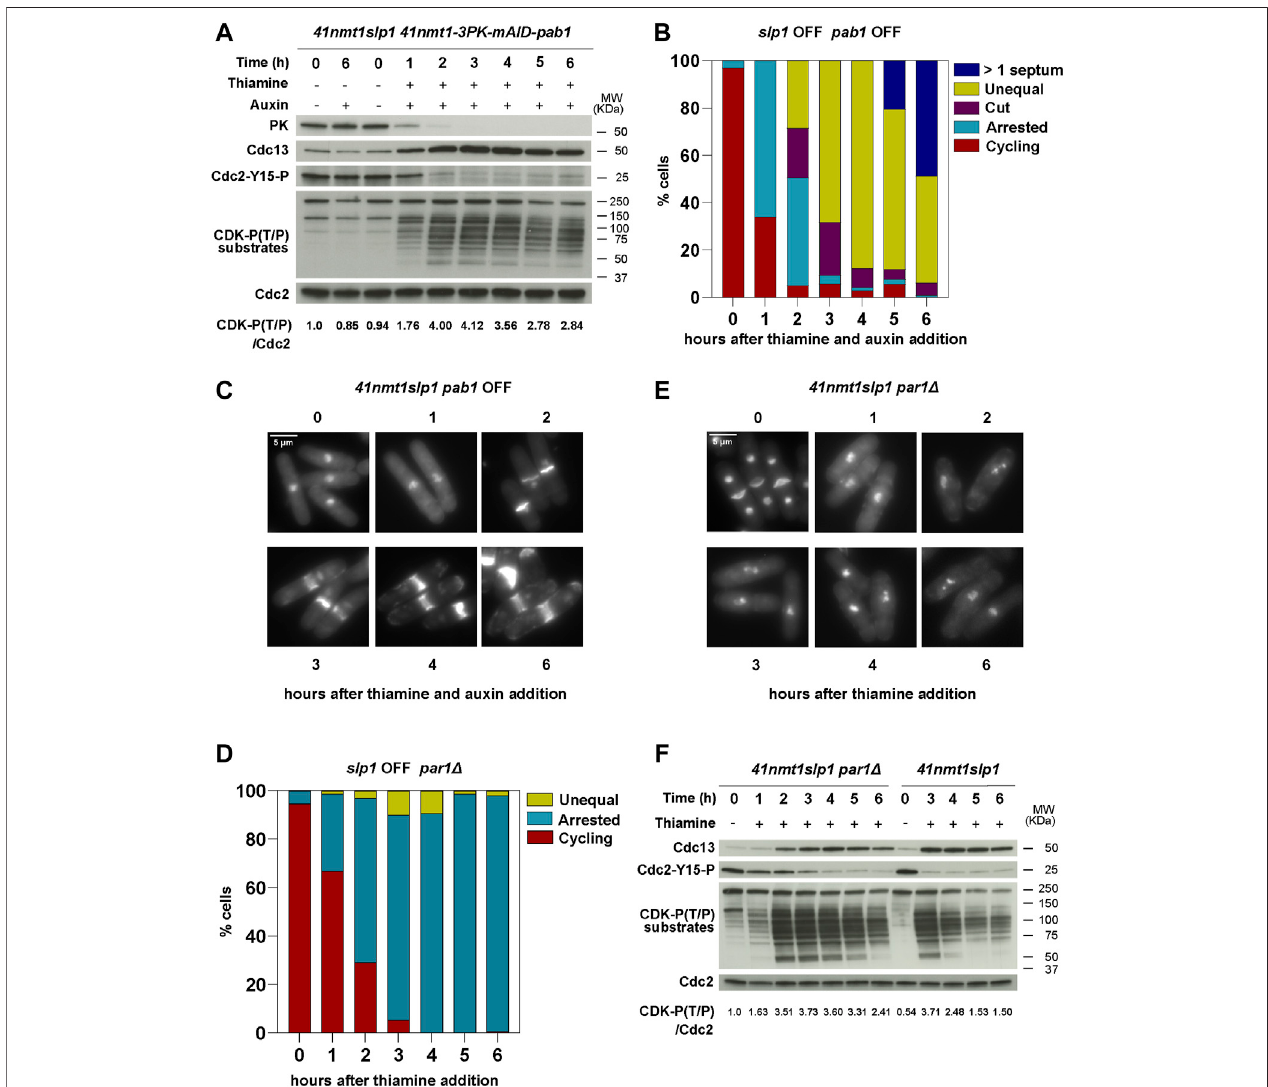
FIGURE 3 | B55 Pab1 and B56 Par1 PP2A-regulatory subunits have opposite effects in the induction of septation in metaphase arrested cells. (A – C) The indicated strains were grown in EMM and then shifted to EMM with 0.5 mM 1-Naphthaleneacetic acid (auxin) for Pab1 degradation and/or 15 µm thiamine ( 41nmt promoter repressed)at30 ° C.Sampleswerecollectedattheindicatedtimepointsformicroscopyandwesternblot. (A) DepletionofPab1wasdetected bywesternblotagainstits N-terminal 3PK tag. See also Supplementary Figure S1 . Cdc13 levels, phosphorylation at T/P sites in CDK substrates and Cdc2 phosphorylated at Y15 served as indicators of CDK activity and were detected by western blot. Cdc2 (PSTAIR) was used as a protein loading control. The numbers under the western blot indicate CDK-substrate Phosphorylation (P-T/P) quanti fi cation relative to Cdc2. (B) The percentage of cyclingcells, metaphase-arrested cells, and arrested cells that underwent cytokinesis (cut or unequal) were determined at the indicated time points after the addition of thiamine to the culture. At least 200 cells were counted per time point. (C) Representative images of mitotic features distributions from DAPI and Blankophor-stained ethanol- fi xed cells of p41-nmt1:slp1p41-nmt1-3PK-miniAID-pab1 in (B) . Scale bar 5 µm. (D – F) p41 - nmt1:slp1 par1 Δ cells were grown exponentially in EMM ( p41-nmt1 promoter induced) and shifted to EMM +T ( p41-nmt1 promoter repressed) at30 ° C.Sampleswerecollectedattheindicatedtime pointsfor microscopy and westernblot. (D) The percentage ofcyclingcells, metaphase-arrestedcells, and arrested cells that underwent cytokinesis (cut or unequal) were determined at the indicated time points after the addition of thiamine to the culture. At least 200 cells werecountedpertimepoint. (E) RepresentativeimagesofmitoticfeaturesdistributionsfromDAPIandBlankophor-stainedethanol- fi xedcellsof p41-nmt1:slp1par1 Δ in (D) . Scale bar 5 µm. (F) Cdc13 levels, phosphorylation at T/P sites in CDK substrates and Cdc2 phosphorylated at Y15 in p41-nmt1:slp1 and p41-nmt1:slp1 par1 Δ strains were detected by western blot. Cdc2 (PSTAIR) was used as a protein loading control. The numbers under the western blot indicate